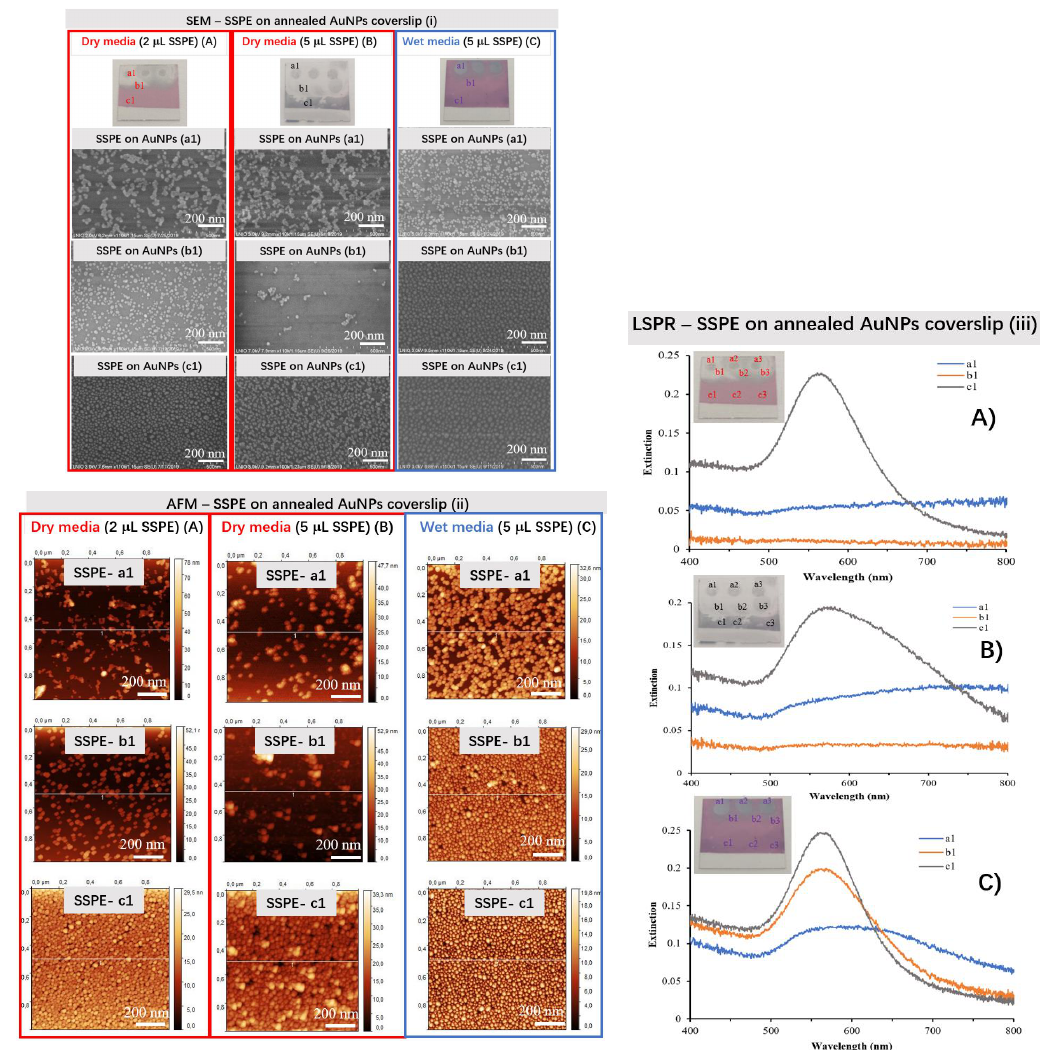
Figure 5. SEM ( i ), AFM ( ii ) and LSPR ( iii ) characterizations of annealed gold nanostructured (AuNPs) coverslips exposed to three drops of SSPE per coverslip with three areas investigated for each deposited/removed drop (a1, under the drop, b1, in the vicinity of the drop, and c1, far from the drop). Two approaches were tested ( A ) 2 μL SSPE drop and ( B ) 5 μL SSPE drop on coverslip for an overnight at 4 °C under dry media; ( C ) 5 μL SSPE drop on coverslip for an overnight at 4 °C under wet media (1 × SSPE buffer, pH = 7.4). The SEM, AFM and LSPR measurements were performed under cleanroom conditions at 21 °C. Three drops of 5 μL PBS buffer were placed on annealed AuNPs and kept under wet media for overnight at 4 °C. The SEM images (Figure 6i) depict a similar behavior of agglomeration of nanoparticles in chains (a1 area) close to those images obtained in the presence of SSPE buffer (5 μL), but under dry media. Very few AuNPs are observed in the b1 area, suggesting a stronger destabilization effect of the PBS buffer over the annealed NPs. These observations are also confirmed by AFM imaging (Figure 6ii) and the corresponding line profile analysis with R rms roughness values of 6.33 for a1, 1.94 for b1 and 2.91 nm for c1.